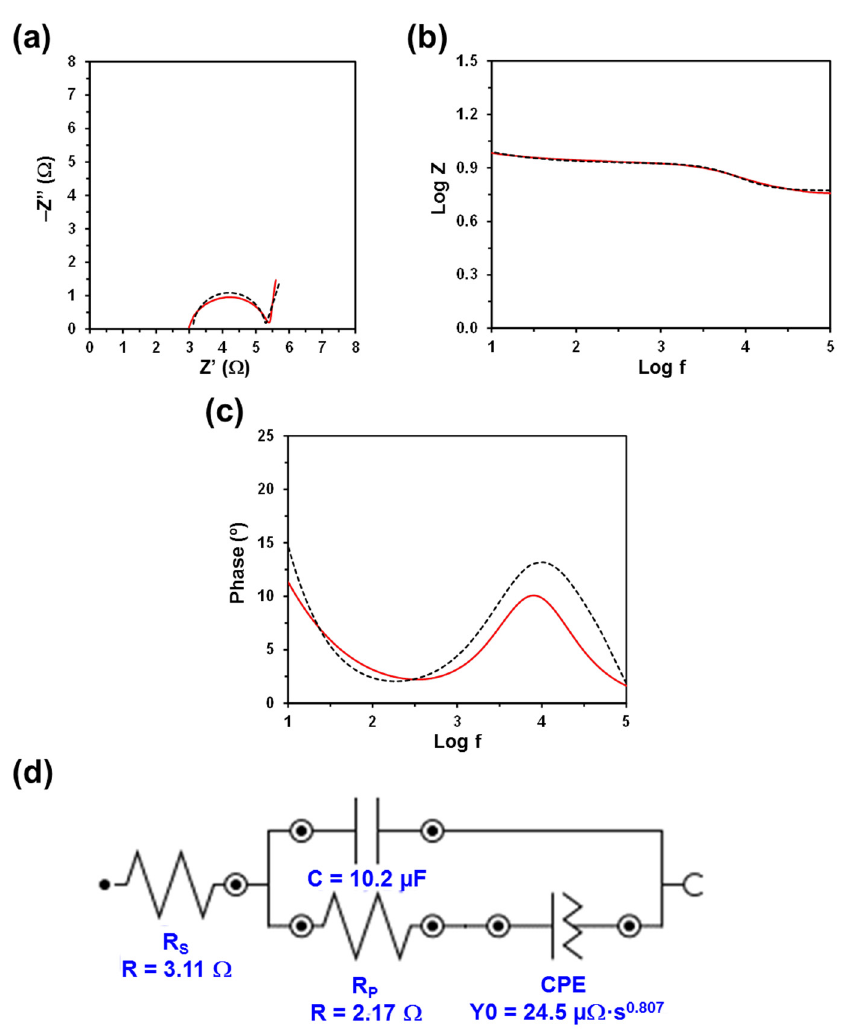
Figure 6. Measured and fitted EIS spectra (solid red line and dashed black line, respectively) for the PEA hydrogel sandwiched between two PEDOT electrodes: ( a ) Nyquist plot; ( b ) impedance Bode plot; and ( c ) phase Bode plot. ( d ) EEC model used for numerical fitting of the EIS data. Numerical results from fitting the spectra are displayed for all the elements of the EEC.